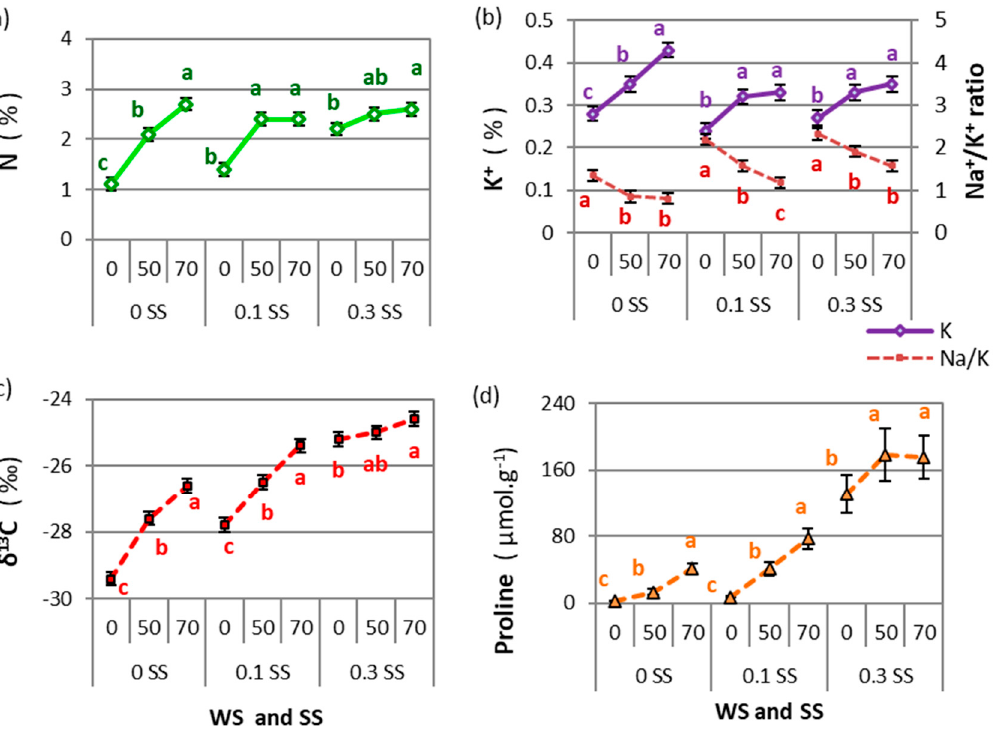
Figure 5. Drought and salinity interactions (WS and SS) for N concentration ( a ), K + concentration and Na + /K + ratio ( b ), stable isotopes of C ( δ 13 C) ( c ), and free proline ( d ). For each variable, different letters show significant differences (LSD, p < 0.05) among drought levels (WS: 0, 50, or 70, corresponding to 100%, 50%, or 30% water capacity, respectively) for each salinity level (SS: 0, 0.1, or 0.3, corresponding to 0.0, 0.1, or 0.3 M NaCl, respectively). Points are means of 4 tall wheatgrass accessions and 5 blocks ( n = 20). Bars indicate the means standard error.